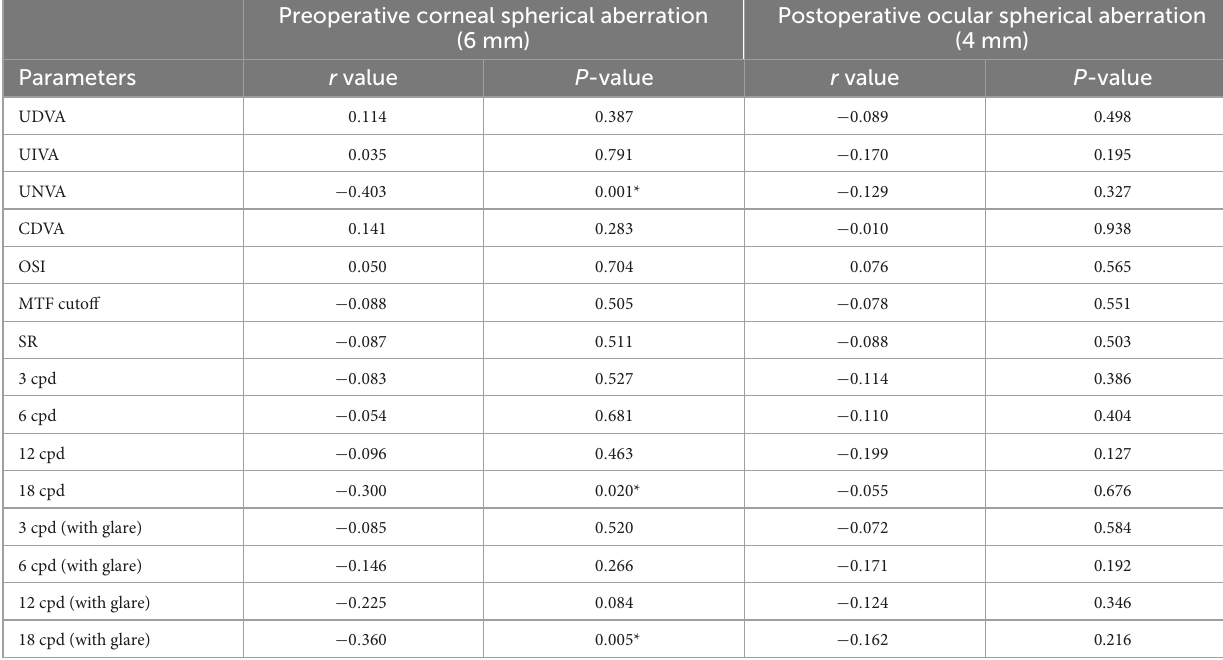
TABLE 2 The relationship between preoperative corneal spherical aberration and some postoperative parameters of visual quality using Spearman’s correlation